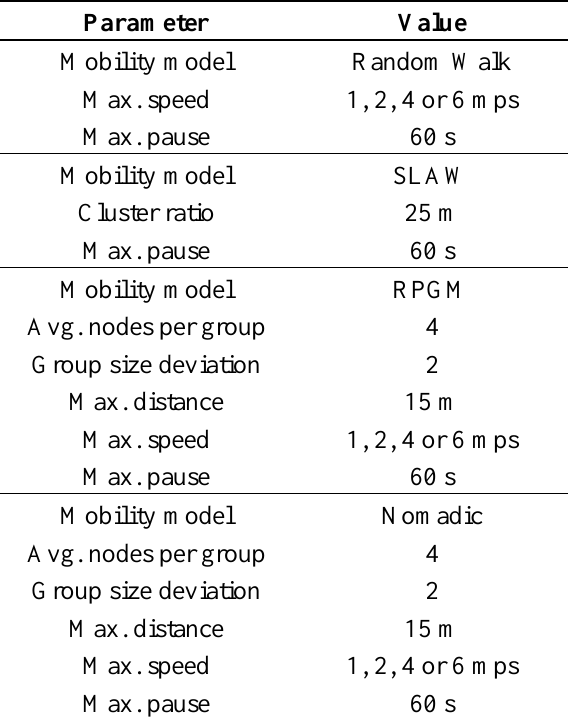
Table 2. Parameters of the mobility